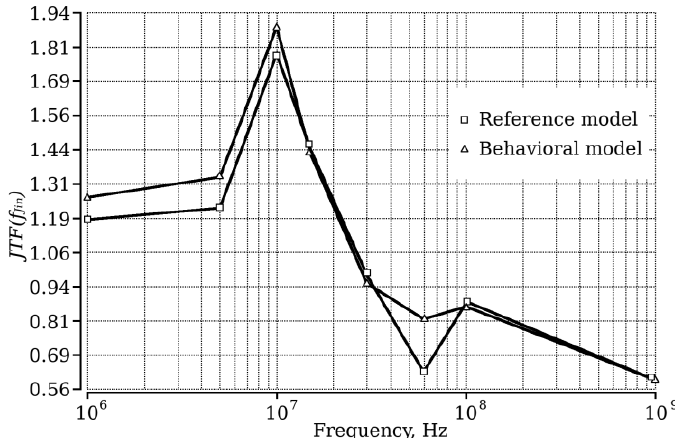
Fig. 3. Characteristic JTF ( f Jin ) calculated using the reference (a square marker) and behavioral (a triangular marker) models.